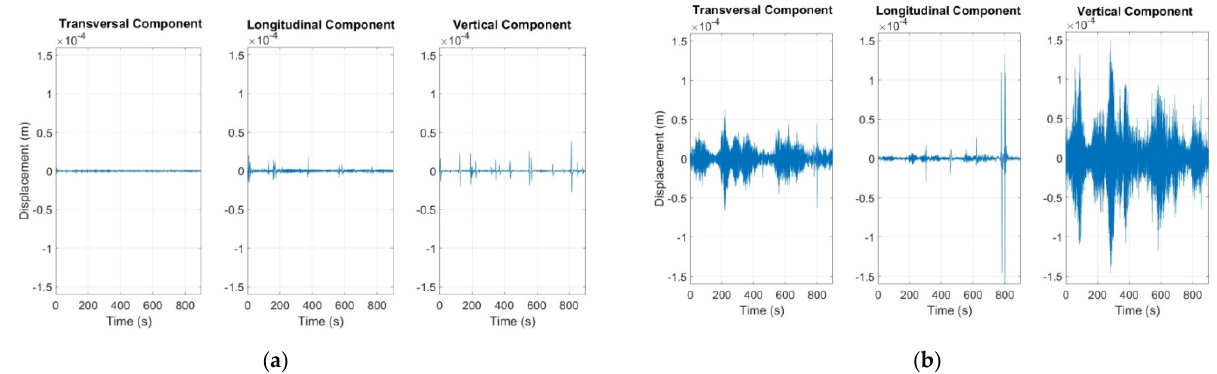
Figure 11. Displacement recordings: ( a ) on the abutment and ( b ) at L/4 on the east edge.